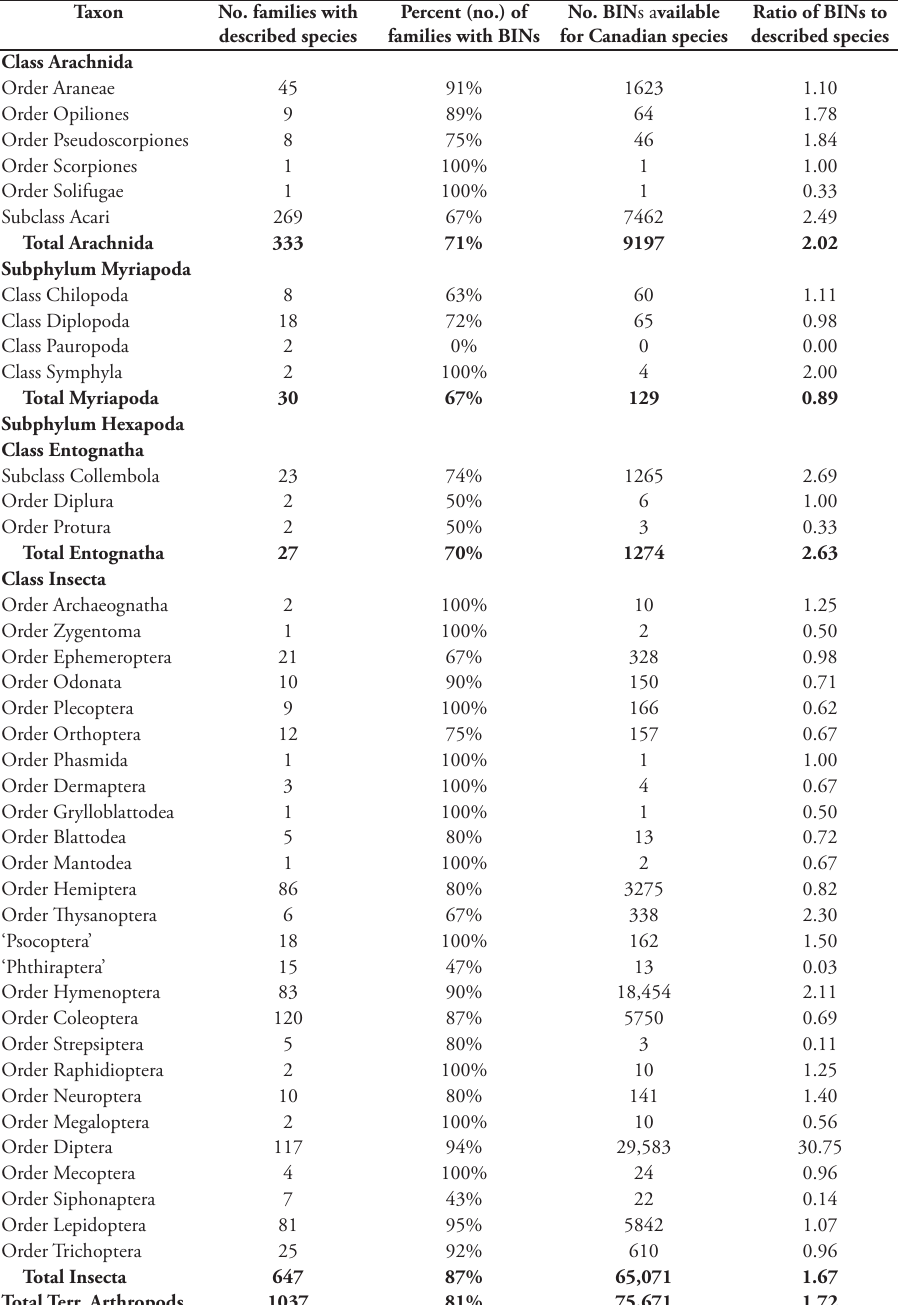
Table 2. Number of Barcode Index Numbers (BINs; Ratnasingham and Hebert 2013) reported for ter- restrial arthropods in Canada and the percent of families with assigned BINs. Data were extracted from each of the faunal papers published in Langor and Sheffield (2019) (see Table 1 for references for each taxon). BIN data were originally obtained from the Barcode of Life Data System